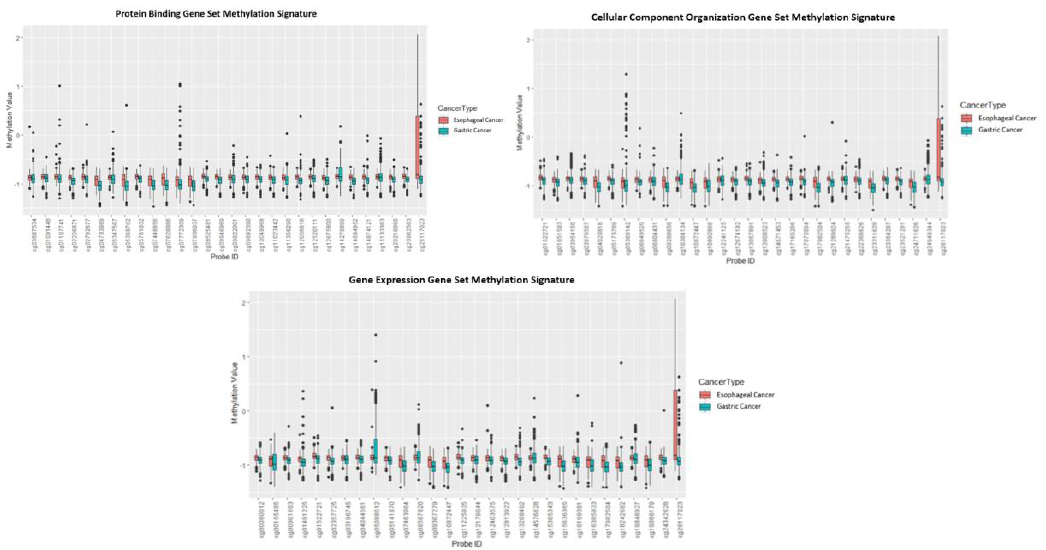
Figure 2. Box plots’ methylation values for all methylation probes in the best performing methylation signatures distinguishing esophageal cancer vs. gastric cancer.